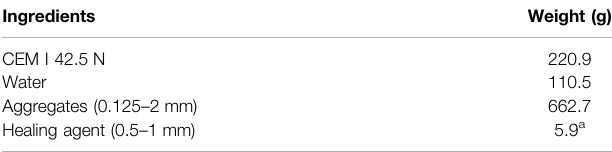
TABLE 4 | Mixing proportions of mortar specimens per kg of mixture. Ingredients